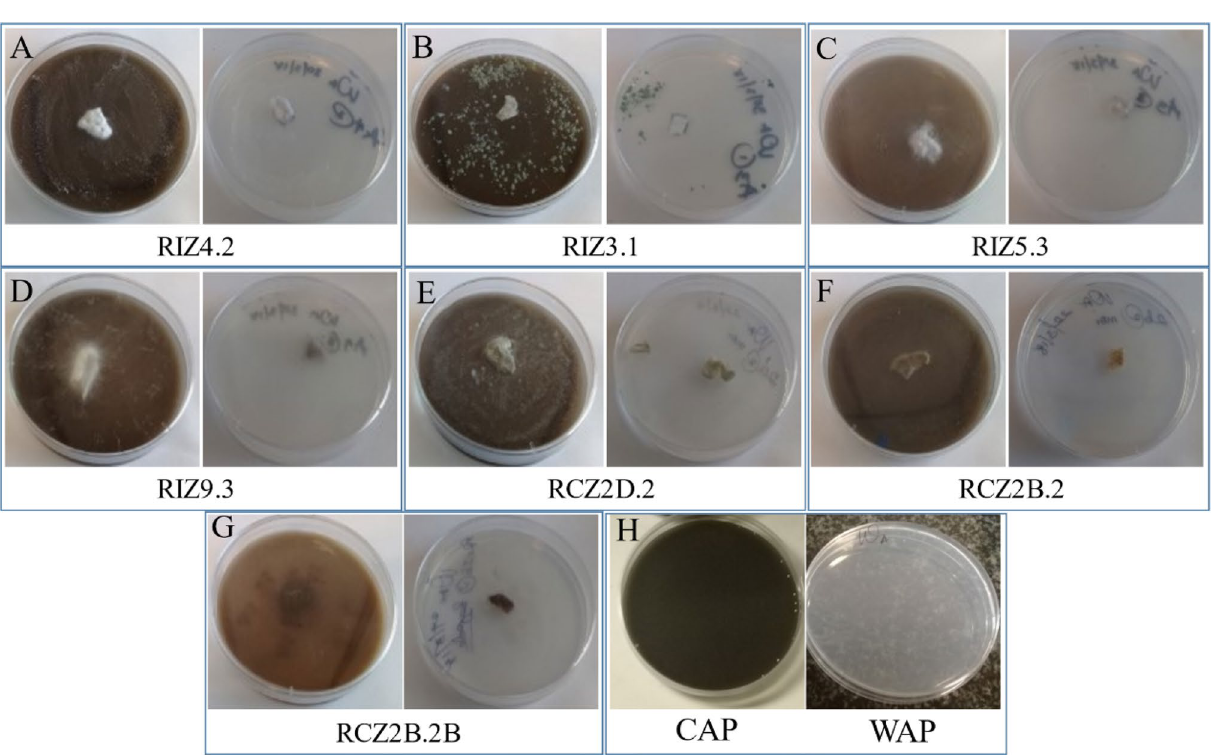
Fig. 1 Representative plates of fungal activity on coal agar plates (CAP) (left) and water agar plates (WAP) (right) and the plant rhizo- spheres from which they were isolated A RIZ4.2 ( Axonopus com- pressus ). B RIZ3.1 ( Emilia coccinea ). C RIZ5.3 ( Synedrella nodiflora ).